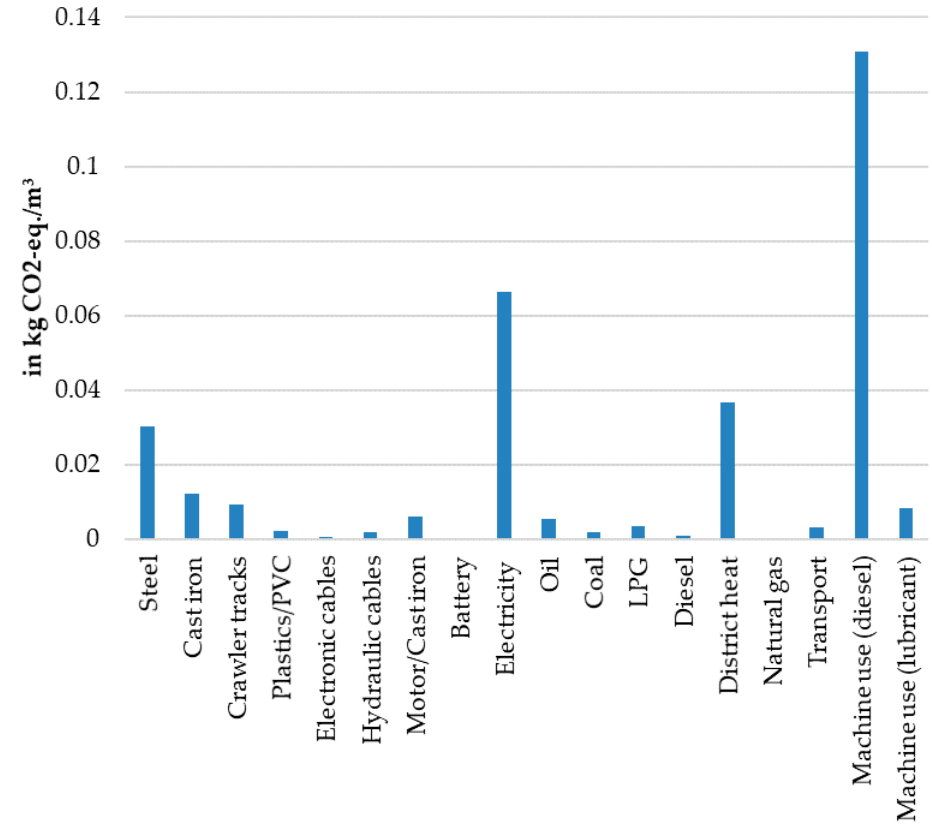
Figure 4. Global warming potential of the manufacture and use of an MFC in kgCO 2 -eq for 1 m 3 of winched timber.